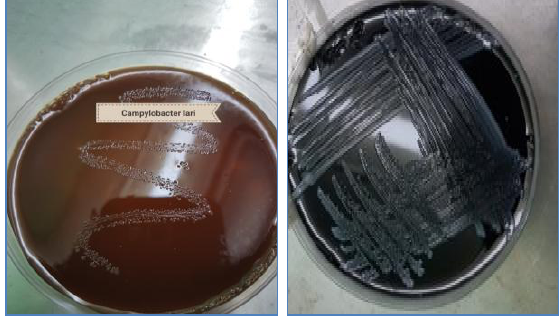
Figure, 1: Growth of Campylobacter spp on selective Preston and MCCD mCCDA plat.